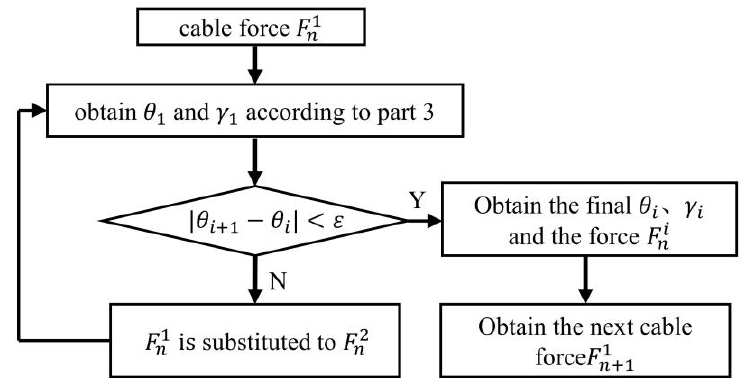
Figure 6. Iterative computation process to solve for bending angle considering the contact friction effect and the coupling effect of forces between multiple notches.